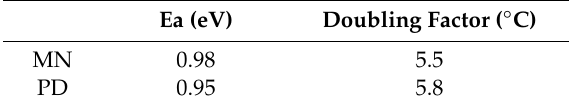
Figure 11. Temperature dependence of the dark current. Table 3. Activation energy and doubling factor of the dark